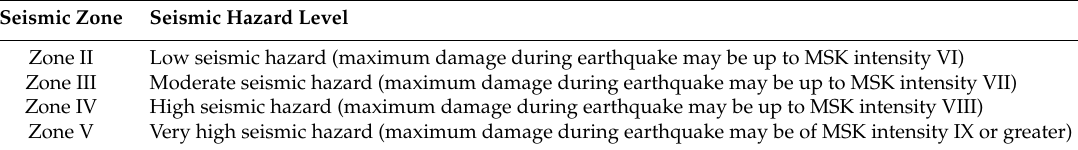
Table 3. Seismic zone classification according to IS 1893:2002 (Part 1)